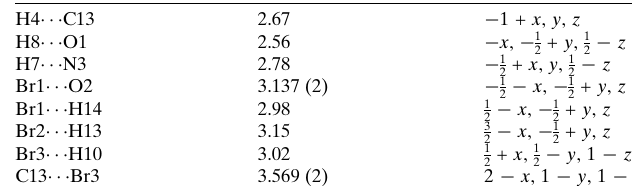
Table 2 Summary of short interatomic contacts (A˚ ) in the title